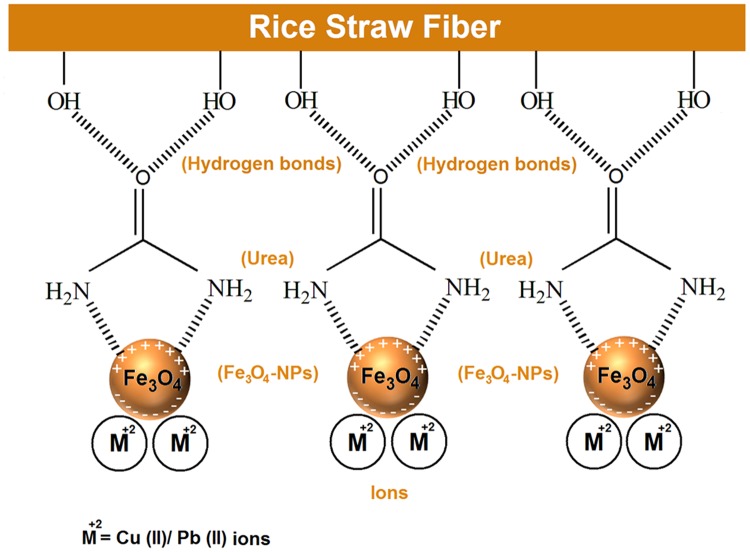
Schematic illustration of adsorption process for Cu(II) and Pb(II) by RS/Fe3O4-NCs.